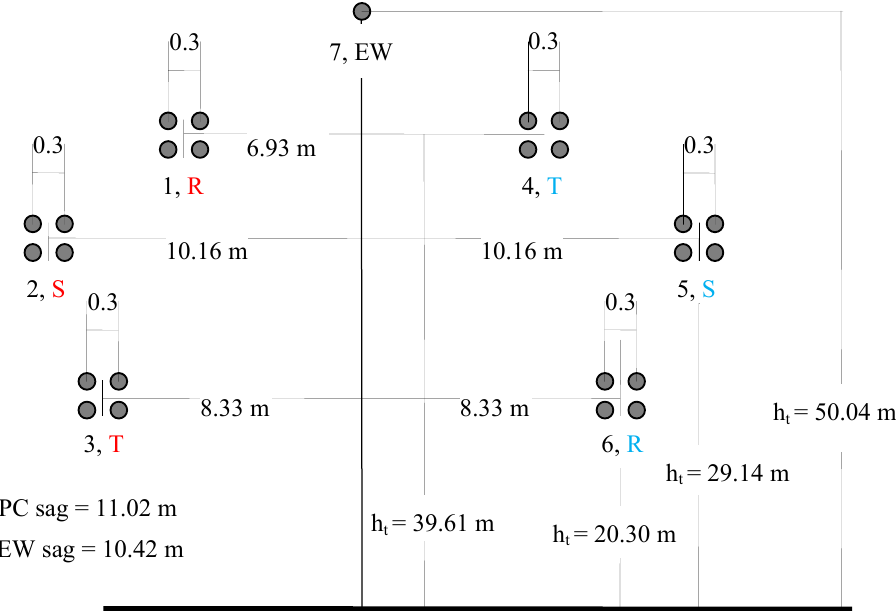
Figure 14. Tower characteristics of 400 kV double-circuit OHL in electric parallel with low reactance phasing.